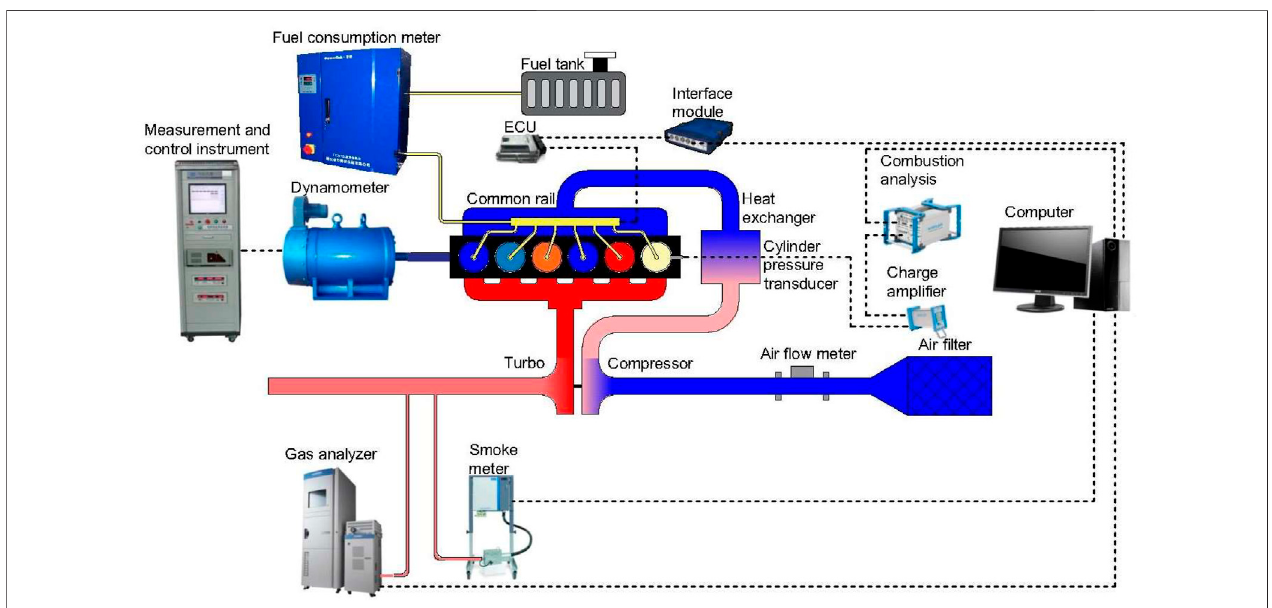
FIGURE 1 | The schematic diagram of the experimental setup.